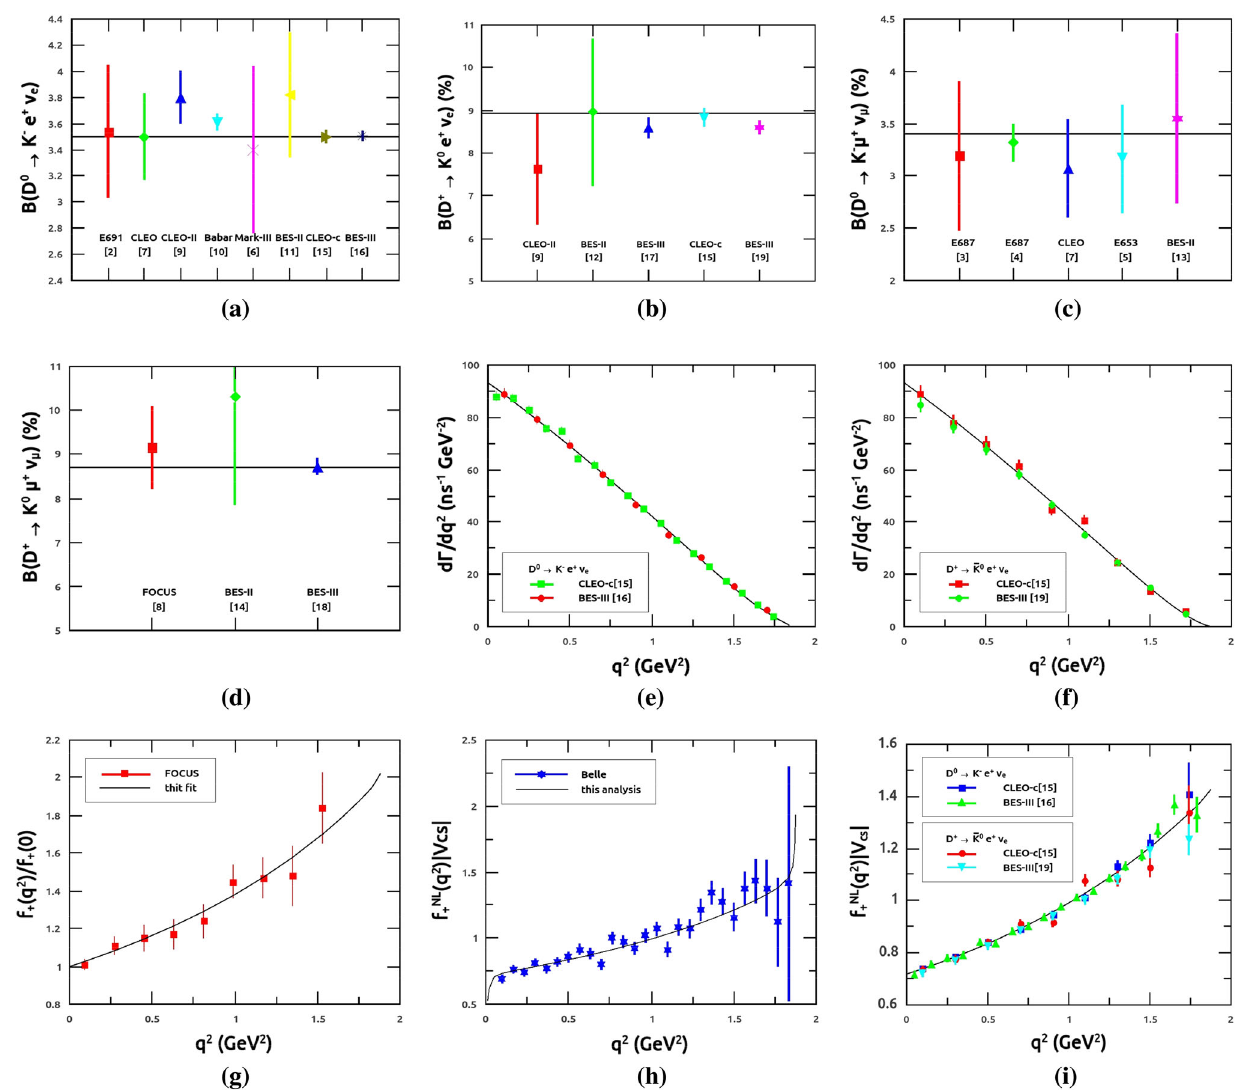
Fig. 2 Fit to the experimental measurements. The black lines are the fitting results, and the different symbols are the measurements from different experiments. The branching fractions for D 0 → K − e + ν e ( a ), D + → ¯ K 0 e + ν e ( b ), D 0 → K − μ + ν μ ( c ) and D + → ¯ K 0 μ + ν μ (d) at different experiments. Differential decay rates measured at the CLEO-c and BES-III experiments for D 0 → K − e + ν e ( e ) and D + → ¯ K 0 e + ν e